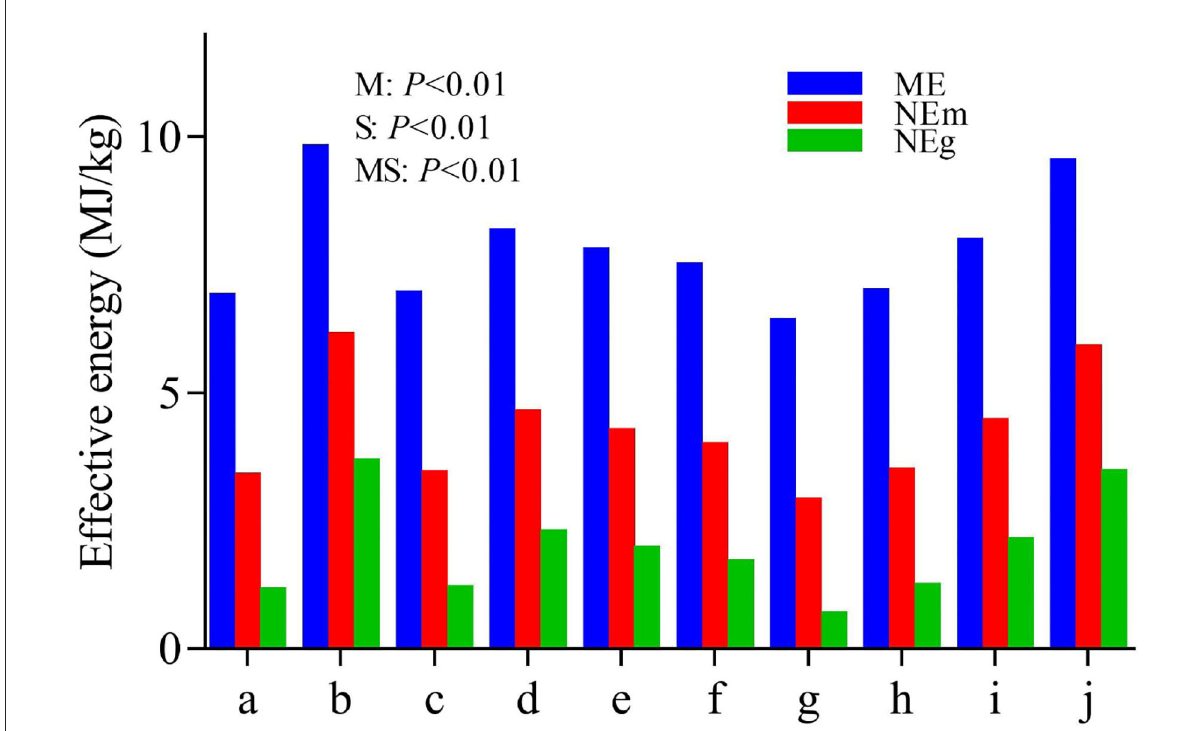
FIGURE6 Predicted effective energy of feedstuff before and after steam explosion processing (a: raw corn cob; b: steam-exploded corn cob; c: raw rice straw; d: steam-exploded rice straw; e: raw peanut shell; f: steamed-exploded peanut shell; g: raw millet stalk; h: steamed-exploded millet stalk; i: raw sugarcane tip; j: steam-exploded sugarcane tip; M: the effect of raw material; S: the effect of processing; MS: the interaction of raw material by